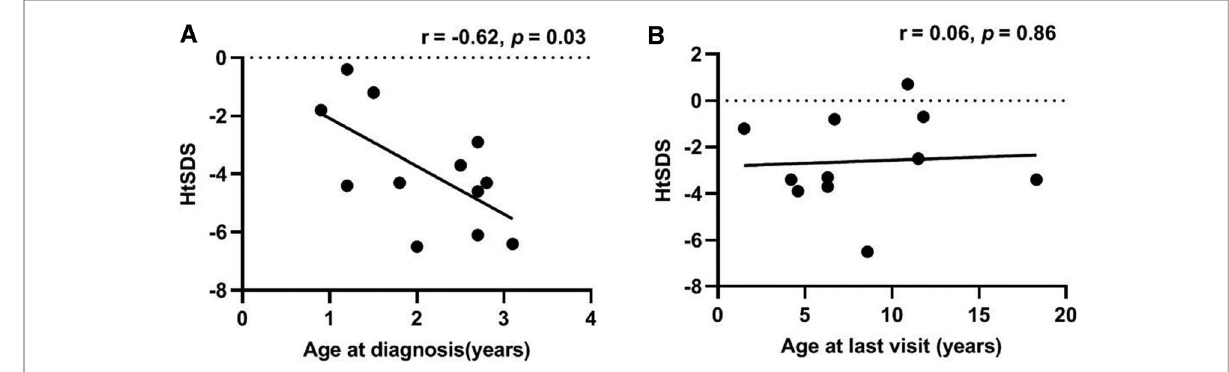
FIGURE 1 Height standard deviation score of children with VDDR1A according to age at diagnosis and at the last